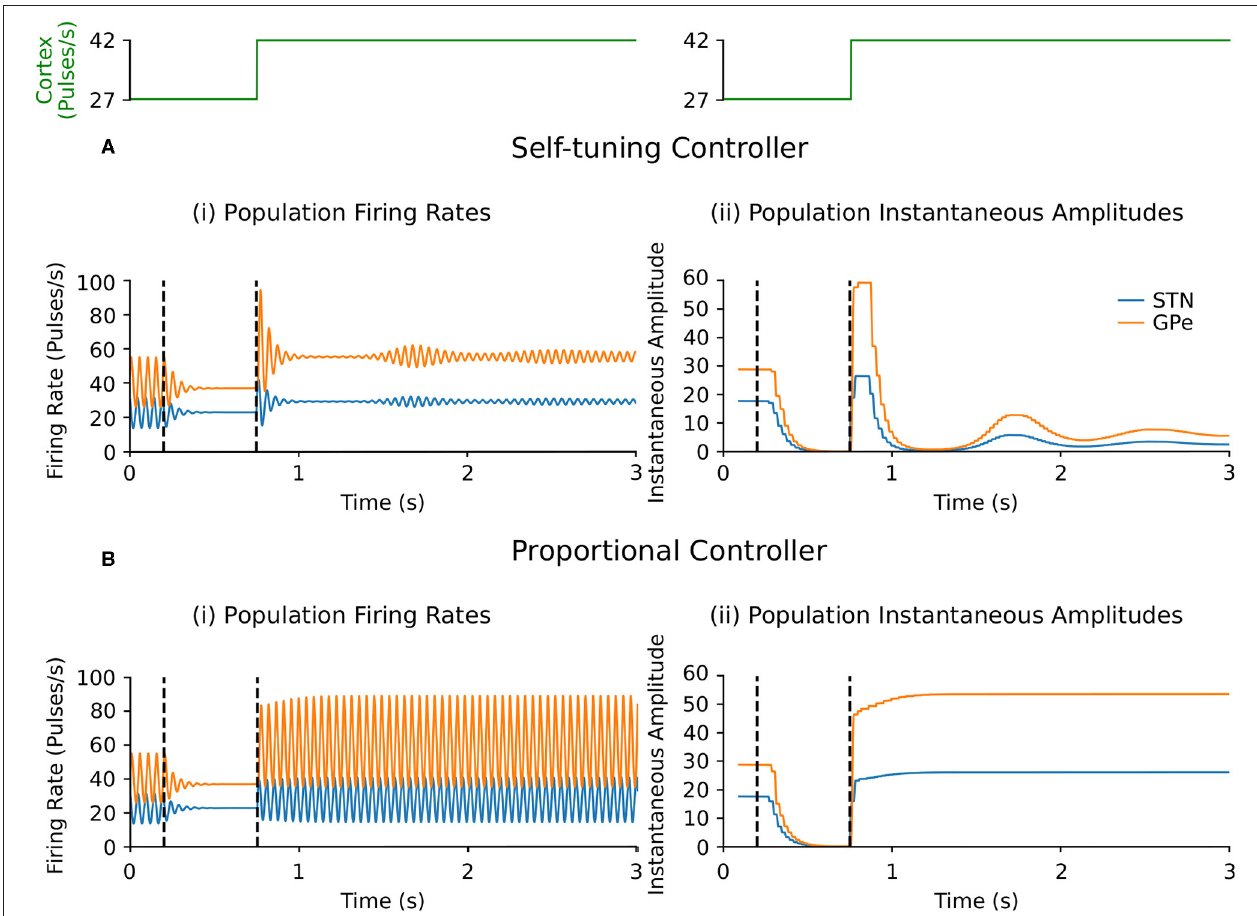
FIGURE 4 | Performance comparison of self-tuning and proportional controllers on endogenous oscillations in the firing-rate model. During simulation, DBS was initially off and then switched on at t = 200 ms, where either the (A) self-tuning controller or (B) proportional controller was implemented. At t = 750 ms, the magnitude of the constant cortical input to STN was artificially increased by from 27 to 42, amplifying the endogenous oscillations present in the STN and GPe. The cortical input is presented in green at the top of the figure, aligned with respect to the simulation time with the plots underneath. Left panels illustrate the firing rate behavior of the STN and GPe populations and the right panels correspond to the instantaneous peak-to-peak oscillation amplitude of each population (measured with a sliding window of 100 ms) due to either (A) the self-tuning controller (7) with τ θ = 75 ms and σ = 0.19 or (B) the proportional controller (4) with θ =